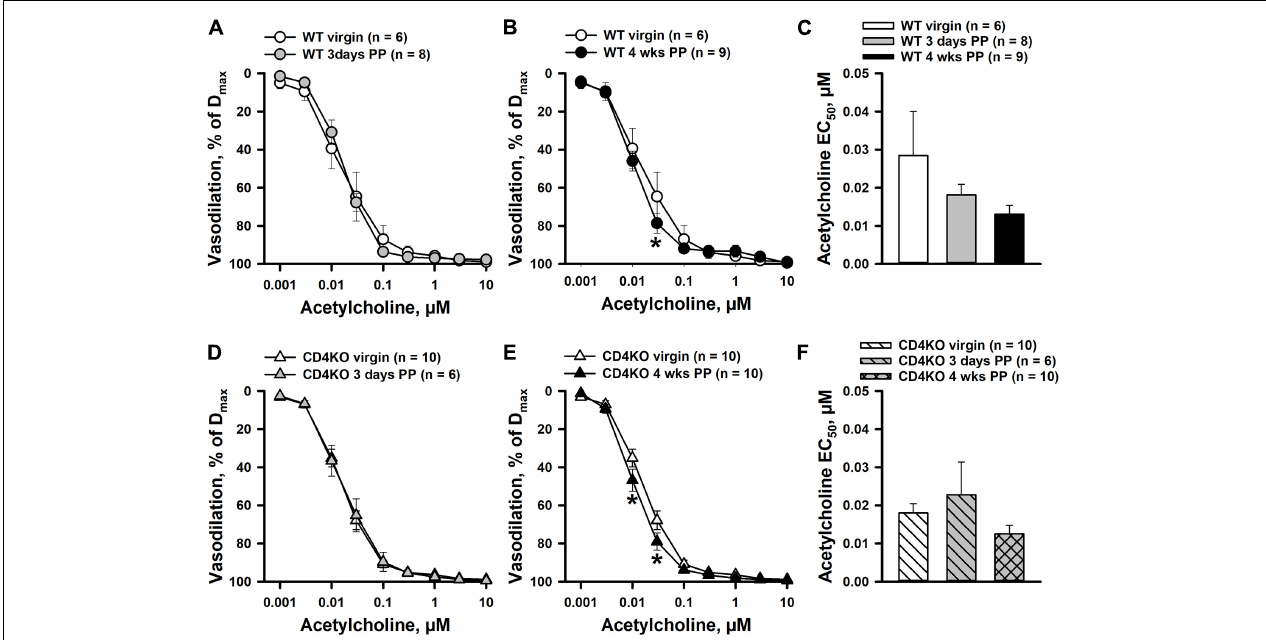
FIGURE 3 | The effects of pregnancy on acetylcholine (ACh)-induced dilation of internal carotid arteries (ICAs) from C57BL/6 wild-type (WT) and CD4 T cell deficient (CD4KO) virgin and postpartum (PP) mice. (A) A summary graph demonstrating no difference in ACh-induced dilator responses of arteries from 3 days PP vs. virgin WT mice ( P > 0.05, two way RM ANOVA). (B) Dilator responses to ACh were increased in 4 weeks PP vs. virgin WT mice (* P < 0.05, two way ANOVA). (C) EC 50 values for ACh-induced vasodilation of arteries from WT PP mice were not significantly different from that of vessels from virgin controls ( P > 0.05, one way ANOVA). (D) Unaltered dilator responses of ICAs to ACh in 3 days PP vs. virgin CD4KO mice ( P > 0.05, two way ANOVA). (E) A summary graph showing an increased reactivity to ACh in ICAs from 4 weeks PP vs. virgin CD4KO mice (* P < 0.05, two way RM ANOVA). (F) A bar graph summarizing EC 50 values for ACh-induced dilation of ICAs from virgin, 3 days and 4 weeks PP CD4KO mice. ( P > 0.05, one way